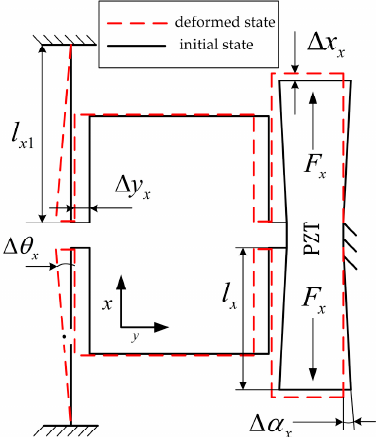
Figure 2. The working principle diagram of micro-platform in the X direction.